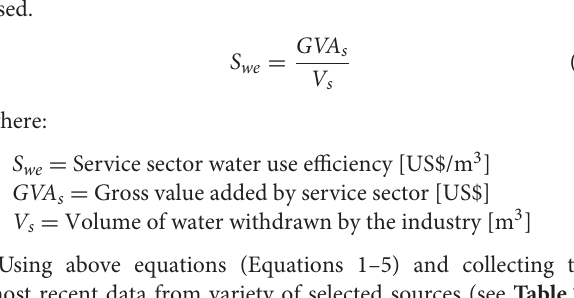
TABLE 4 | Metadata information of developed GIS layers.